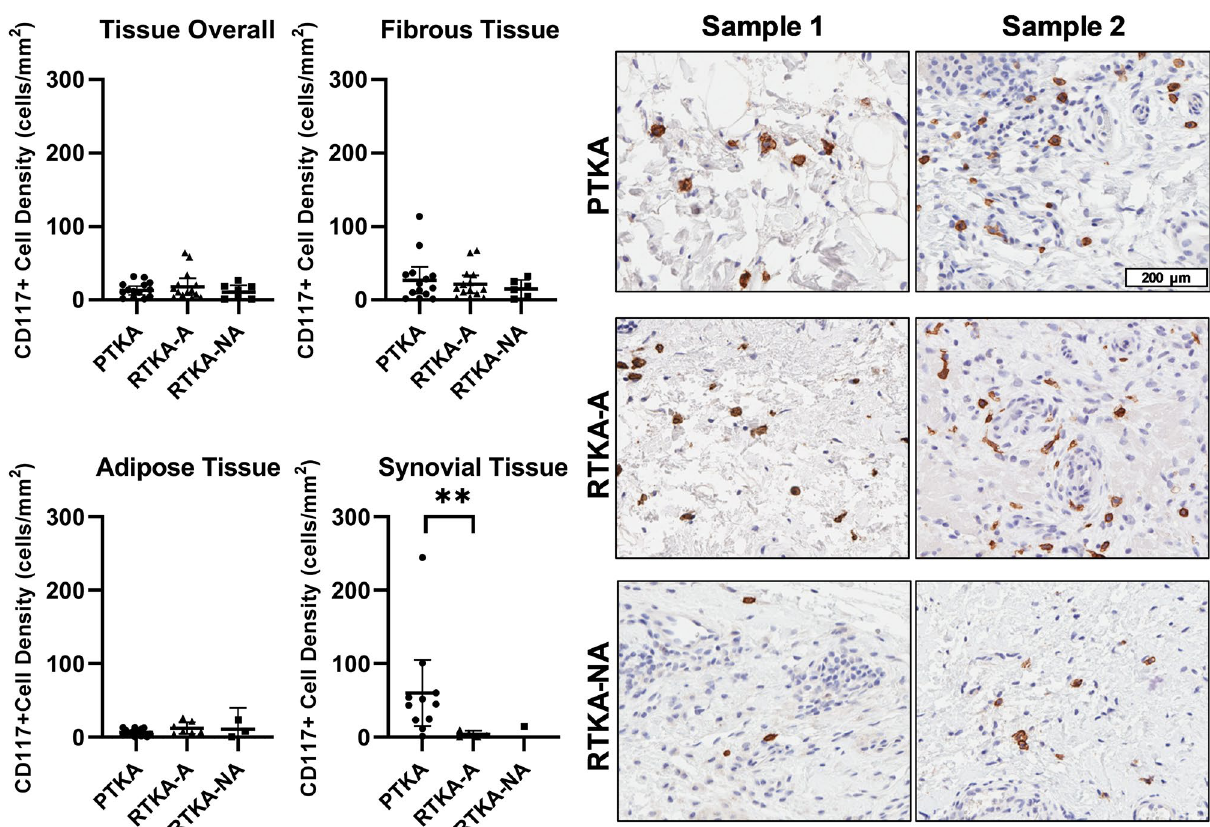
mean mast cell density (CD117 + cell/mm 2 ) ± standard deviation, with each data point representing one